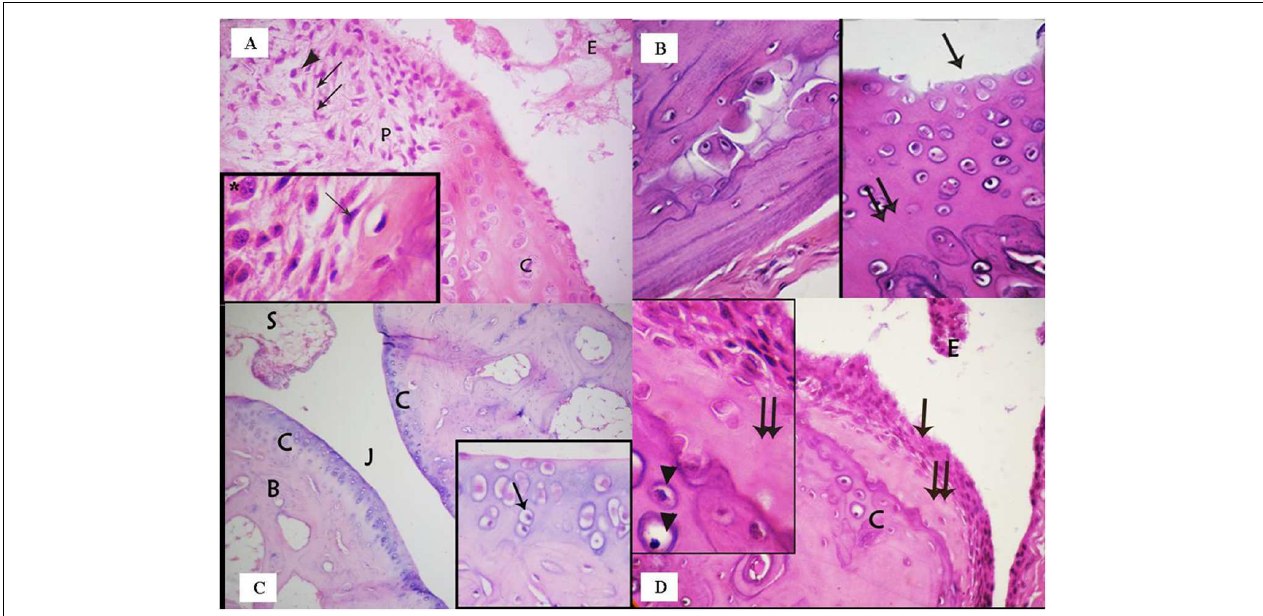
FIGURE 3 | (A) photomicrograph of the rheumatoid arthritis group showing infiltration of the synovial tissue by fibroblast – like spindle shaped cells ( ↑ ) and inflammatory cells, e.g., plasma cells ( (cid:78) ). Note that the nearby articular cartilage (C) has lost its basophilia. Notice also inflammatory cells and exudate (E) in the joint cavity. Inset: higher magnification of spindle shaped cells ( ↑ ) and plasma cells ( ∗ ) in the synovium. (Arthritis group, H & E, × 400; Inset × 1000). (B) Photomicrograph of arthritis group showing: (a) areas of bone destruction within the bone matrix; (b) irregular surface of the articular cartilage with erosion on the surface ( ↑ ) and loss of its smooth contour. Note also areas of cell loss ( ↑↑ ). (Arthritis, H & E, × 400). (C) Photomicrograph of the ankle joint of the group treated with a methanolic extract of the fungus, showing the articular cartilage (C), the joint cavity (J), and synovial membrane (S). Few degenerated cells are evident ( ↑ ). (Methanolic extract group. H & E, × 100; Inset × 400). (D) Photomicrograph of the group treated with an ethanolic extract of the fungus showing the articular cartilage (C) covered by hyperplastic synovium ( ↑ ). The underlying cartilage has lost its basophilia and many chondrocytes appear degenerated. Inset: acidophilic matrix, area of cell loss ( ↑↑ ), and apoptotic chondrocytes ( (cid:78) ). (Ethyl acetate extract group, H & E, × 400; Inset × 1000).